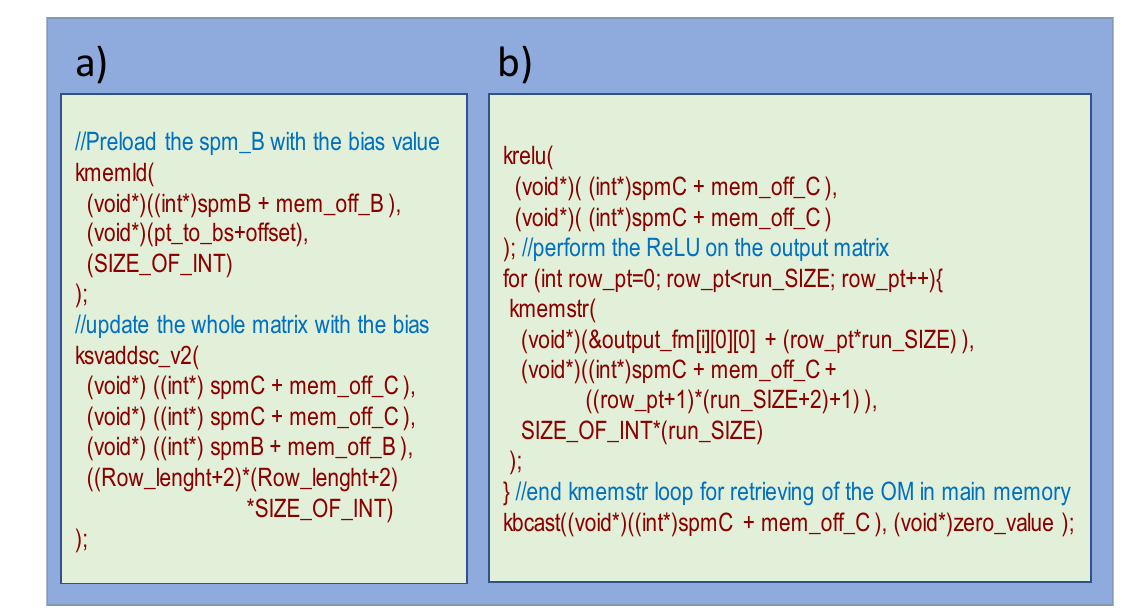
Figure 12. ( a ) Adding the bias to the Output Matrix; ( b ) Applying the ReLu function to the Output Matrix (Layers: 1, 2, 4, 5, 7, 8, 9, 11, 12, 13, 15, 16, 17).